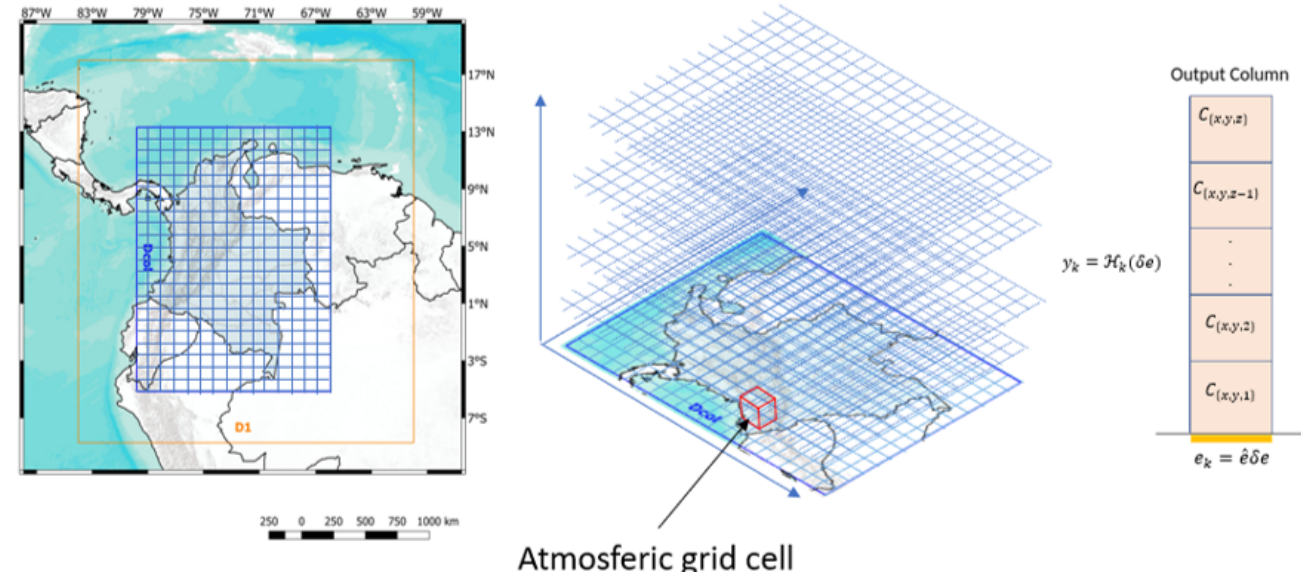
Figure 1. Illustration of simulation domains and vertical extent. ( Left ) Simulation nested domains. ( Right ) A conceptual state representation in the gridded model and the column being sampled by the observation operator that maps the emission parameters to the observation space H k ( δ e ) (see Section 3).